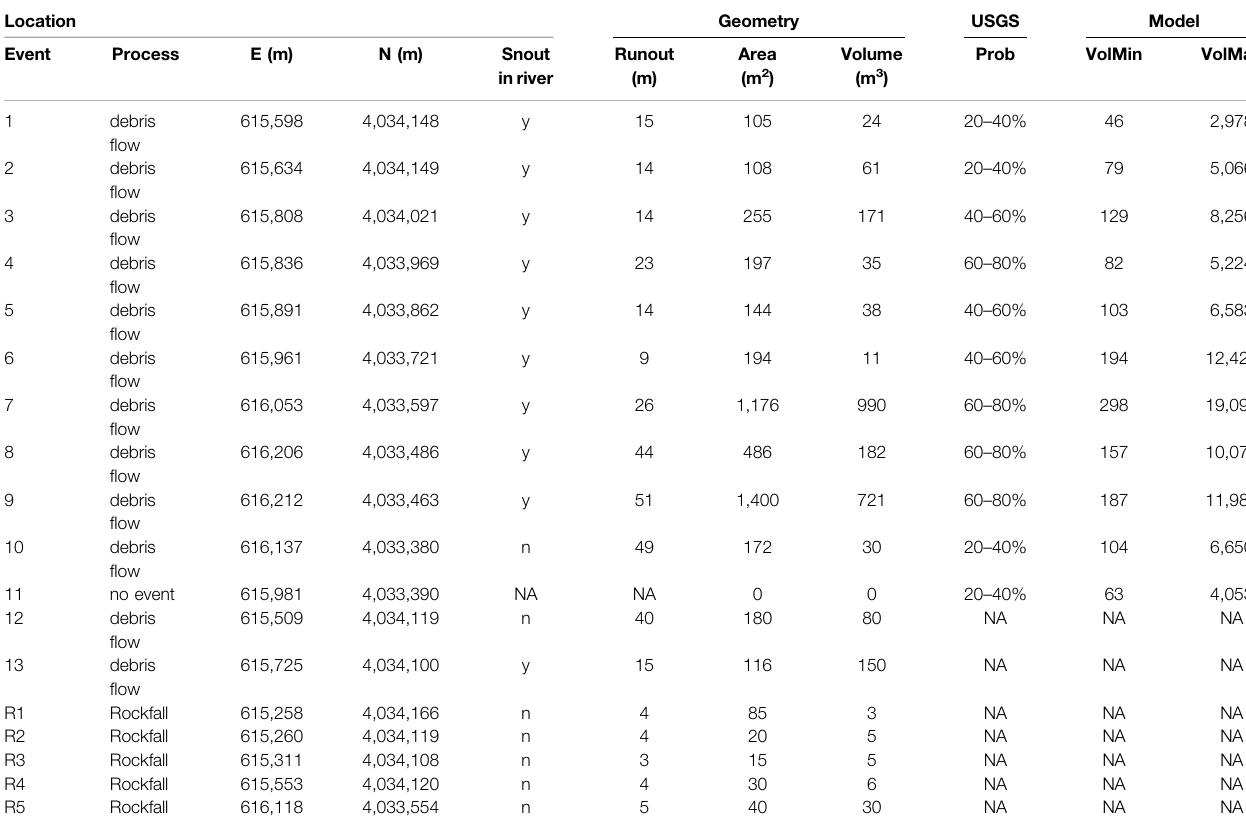
TABLE 2| Debris fl owand rockfalldepositinventoryatthestudysite. Sitelocationsin Figure 4 .Locations areUTMNAD83UTM zone10 N.USGS modelvaluesaredebris fl ow forecasts from USGS (2020). VolMin and VolMax show the range of debris fl ow volume estimates modeled by USGS (2020).